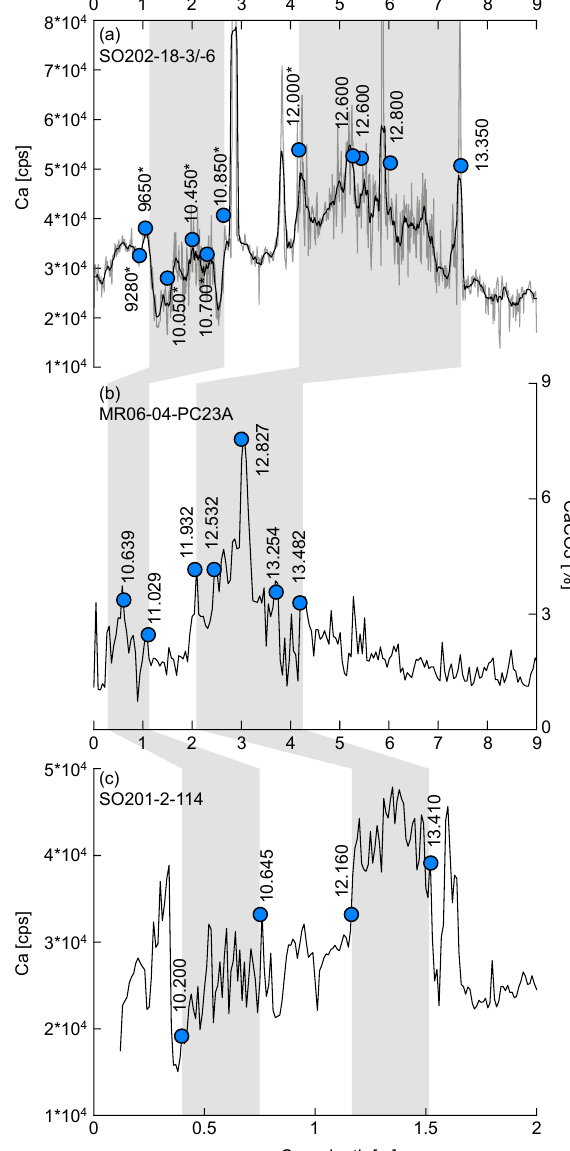
Figure 6. Regional stratigraphic framework based on established basin-wide carbonate peak patterns (Max et al., 2012; Keigwin et al., 1992). Comparison of core SO202-18-3 (this study) to published Bering Sea records with radiocarbon age control and laminated sed- iment sections. (a) Ca XRF counts of SO202-18-3; thick black line shows the 11-point moving average of the Ca data. 14 C ages in this graph marked with asterisks are from SO202-18-6 and were trans- ferred to the corresponding depths of SO202-18-3 through core- core correlation. One 14 C age is not plotted, as it shows an age reversal (see text for details). (b) Core MR06-04-PC23A (Itaki et al., 2009; Rella et al., 2012). (c) Core SO201-2-114 (Max et al., 2012). Blue circles denote radiocarbon dates age with raw, uncali- brated 14 C ages. Gray shading indicates anoxic (laminated/layered) core